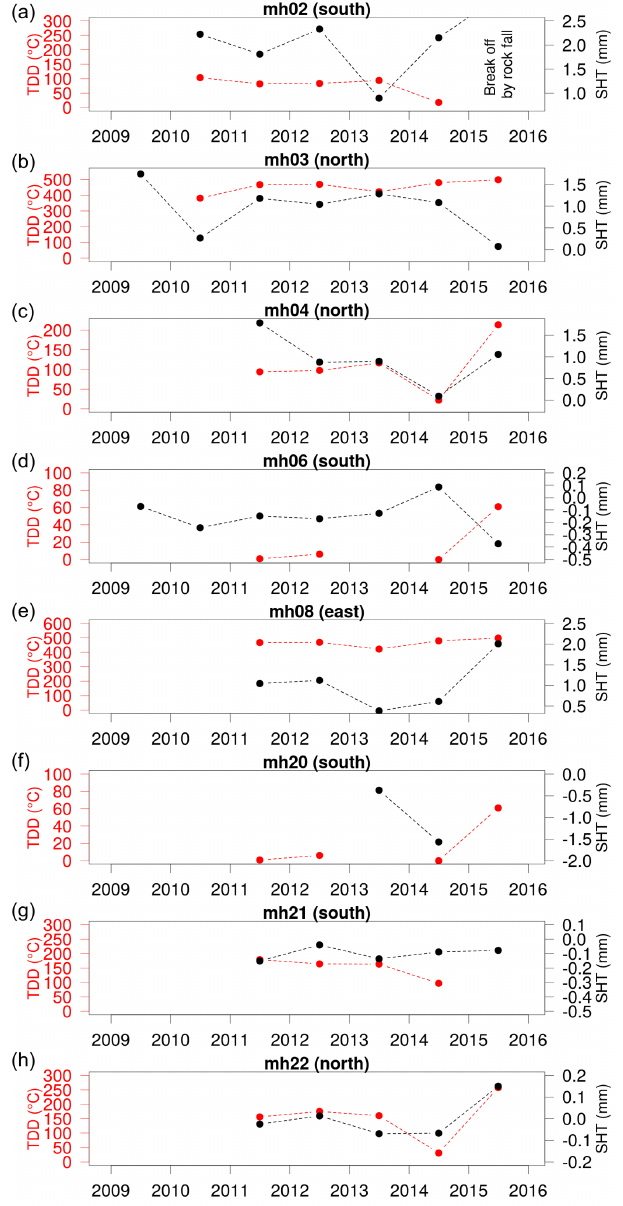
Figure 9. Interannual variability of thawing degree days (TDD) and summer shift of fracture kinematics (SHT) perpendicular to frac- tures for all locations. Data at location mh02 are missing from 2015 onwards due to the break-off and the TDD values at a few loca- tions for the year 2014 are removed due to missing or incomplete temperature